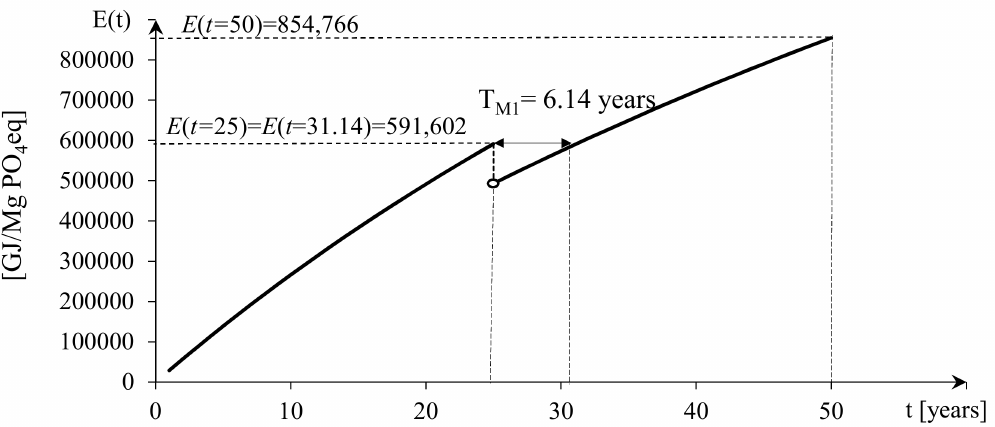
Figure 7. A graphical interpretation of the integrated ecological e ffi ciency indicator from PO 4 emissions for a wind power plant undergoing modernization during a 50-year period of use.